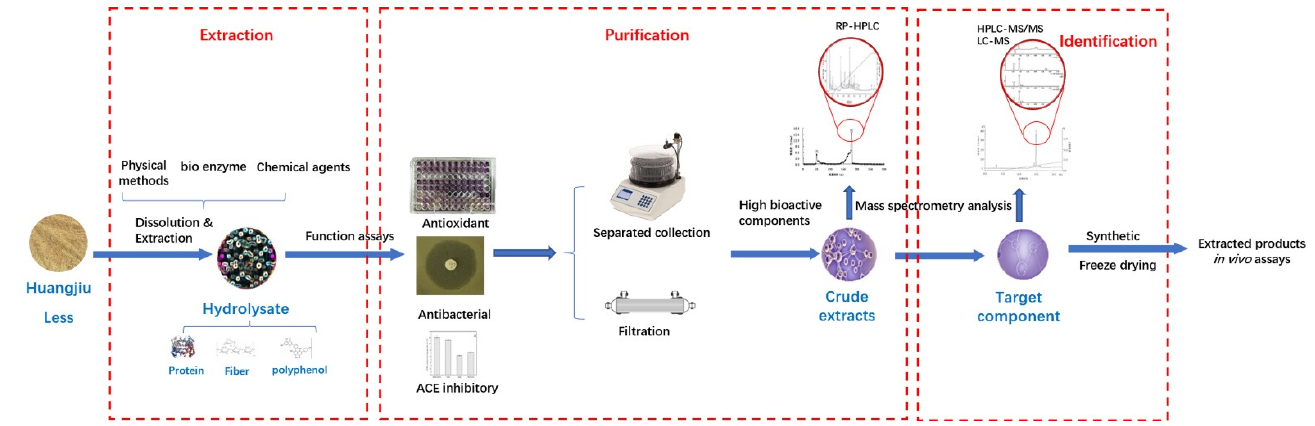
Figure 2. Flow for biological functional components extraction [81,82,84].